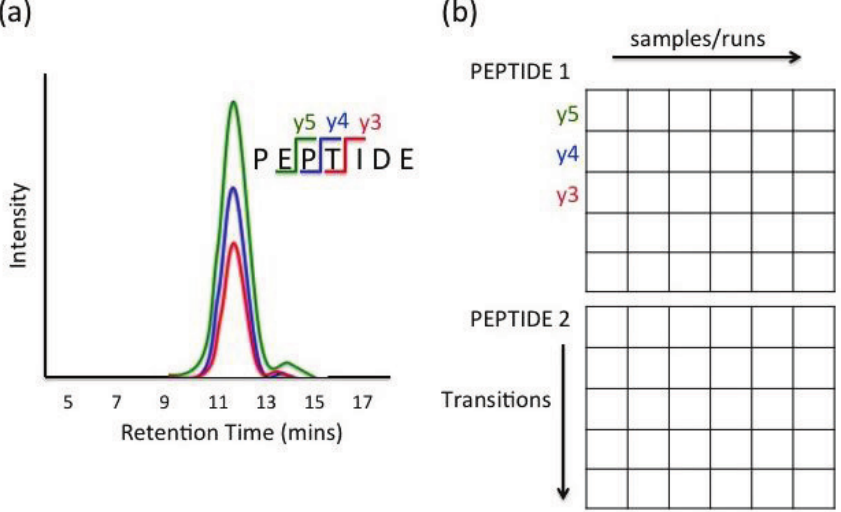
Figure 1. ( a ) Example of three Multiple Reaction Monitoring (MRM) extracted ion chromatograms from a single precursor ion ( b ) Data structure grouped by precursor ion (peptide)